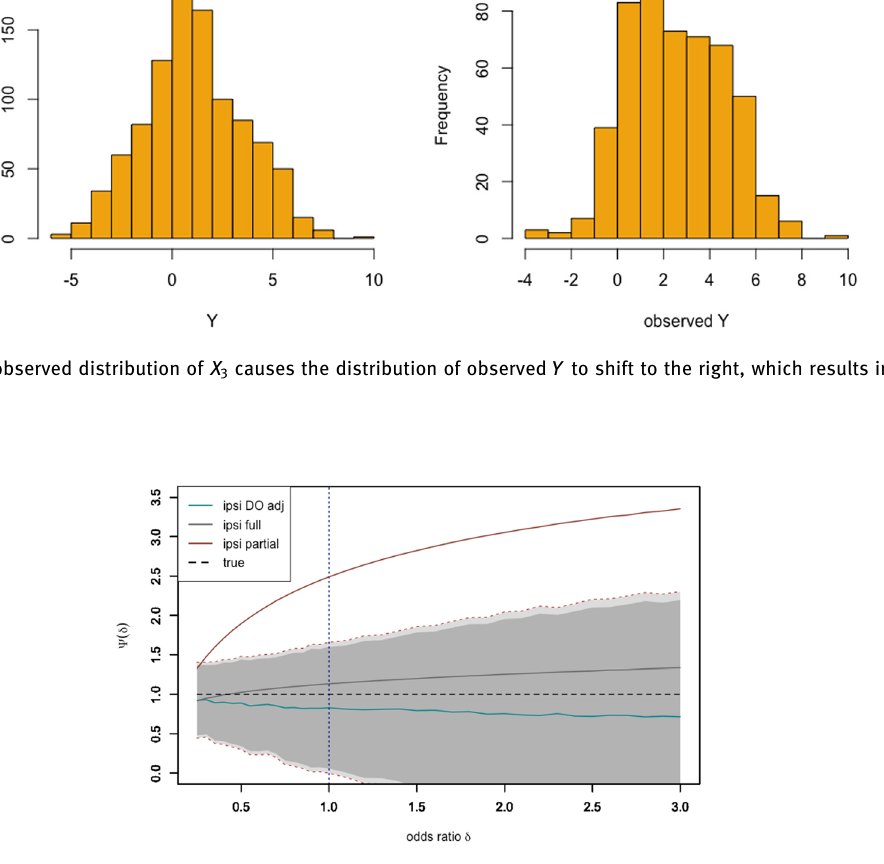
Figure A3: Estimates of the incremental e ff ect using observed data ( ipsi partial ) are largely deviated upward from the true values, and the ones using full data ( ipsi full ) , whereas our proposed method ( ipsi DO adj ) successfully adjusts for